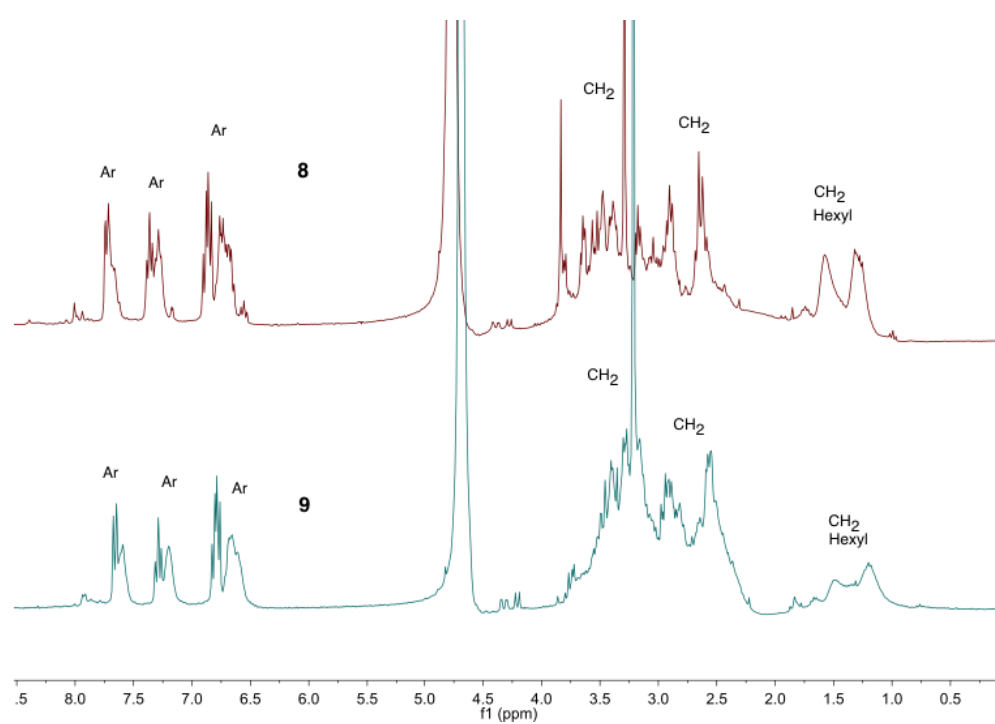
Figure 2. Proton nuclear magnetic resonance, 1 H NMR, spectra of the olsalazine-PAMAM-conjugates of salicylic acid (8) and (9) in D 2 O.